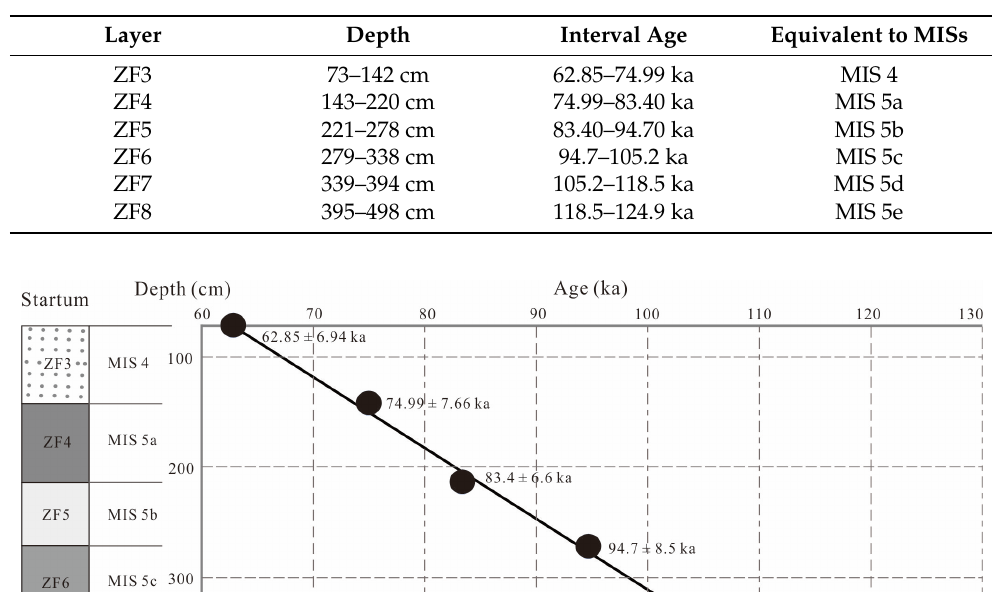
Table 3. Chronological range of each stratum in the ZFS and corresponding MISs.